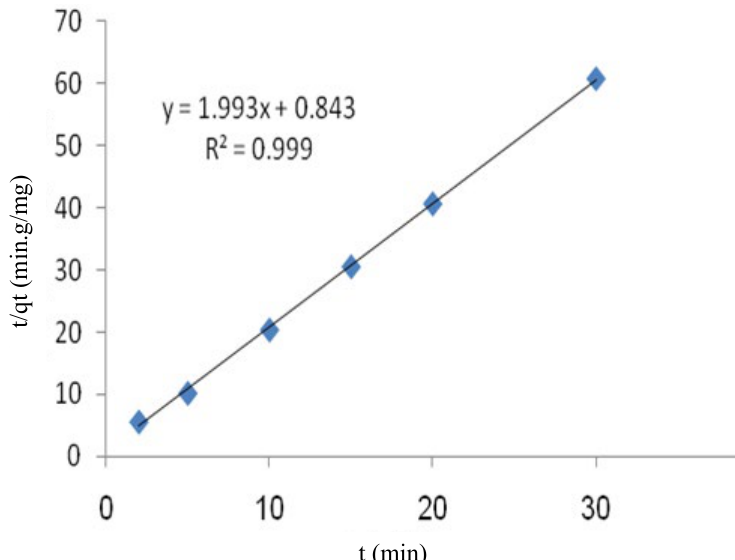
Fig. 7. Pseudo-second-order kinetics for lead removal using the prepared Fig7